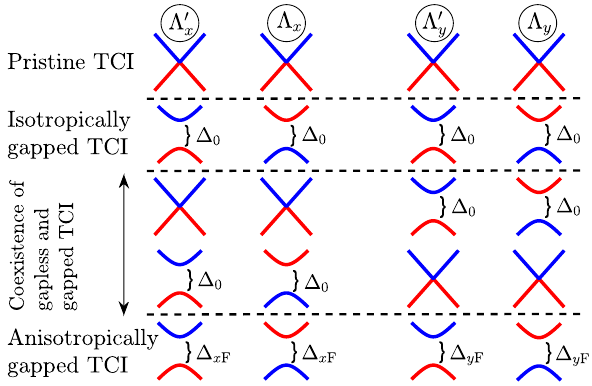
Figure 4. Two-band energy spectrum of four possible configurations for the gapes (cid:31) x F and (cid:31) y F , namely pristine TCI, isotropically gapped TCI, coexistence of gapless and gapped TCI, and anisotropically gapped